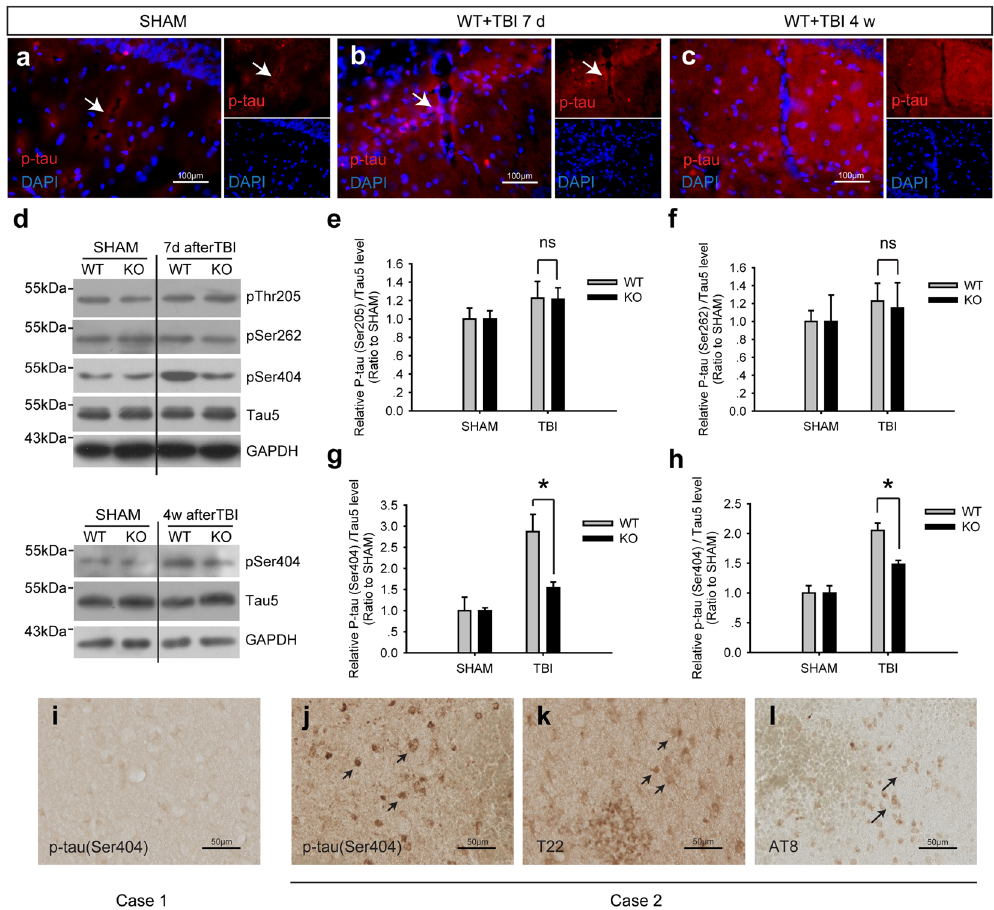
Figure 2. Levels of hyperphosphorylated tau protein increased after TBI. ( a–c ) P-tau (red) accumulation (arrows) was observed in the contralateral hippocampus 7 d and 4 w after TBI in a mouse model. Scale bar: 100 μ m. ( d ) Phosphorylation level of tau in the contralateral hippocampus of WT and A 2A R KO mice 7 d ( e–g ) and 4 weeks ( h ) after TBI was detected and quantified using western blotting. n = 4 per group. Data represent mean ± s.e.m., ns p > 0.05, * p < 0.05, one-way ANOVA. Full length blots are presented in Supplementary Figure S1. ( i ) Relatively less p-tau abnormality was detected in the patient brain tissue of case 1. Immunoreactivity against p-tau at Ser404 ( j ), T22 ( k ) and AT8 ( l ) increased significantly in the case 2 TBI patient. Scale bar: 50 μ m.